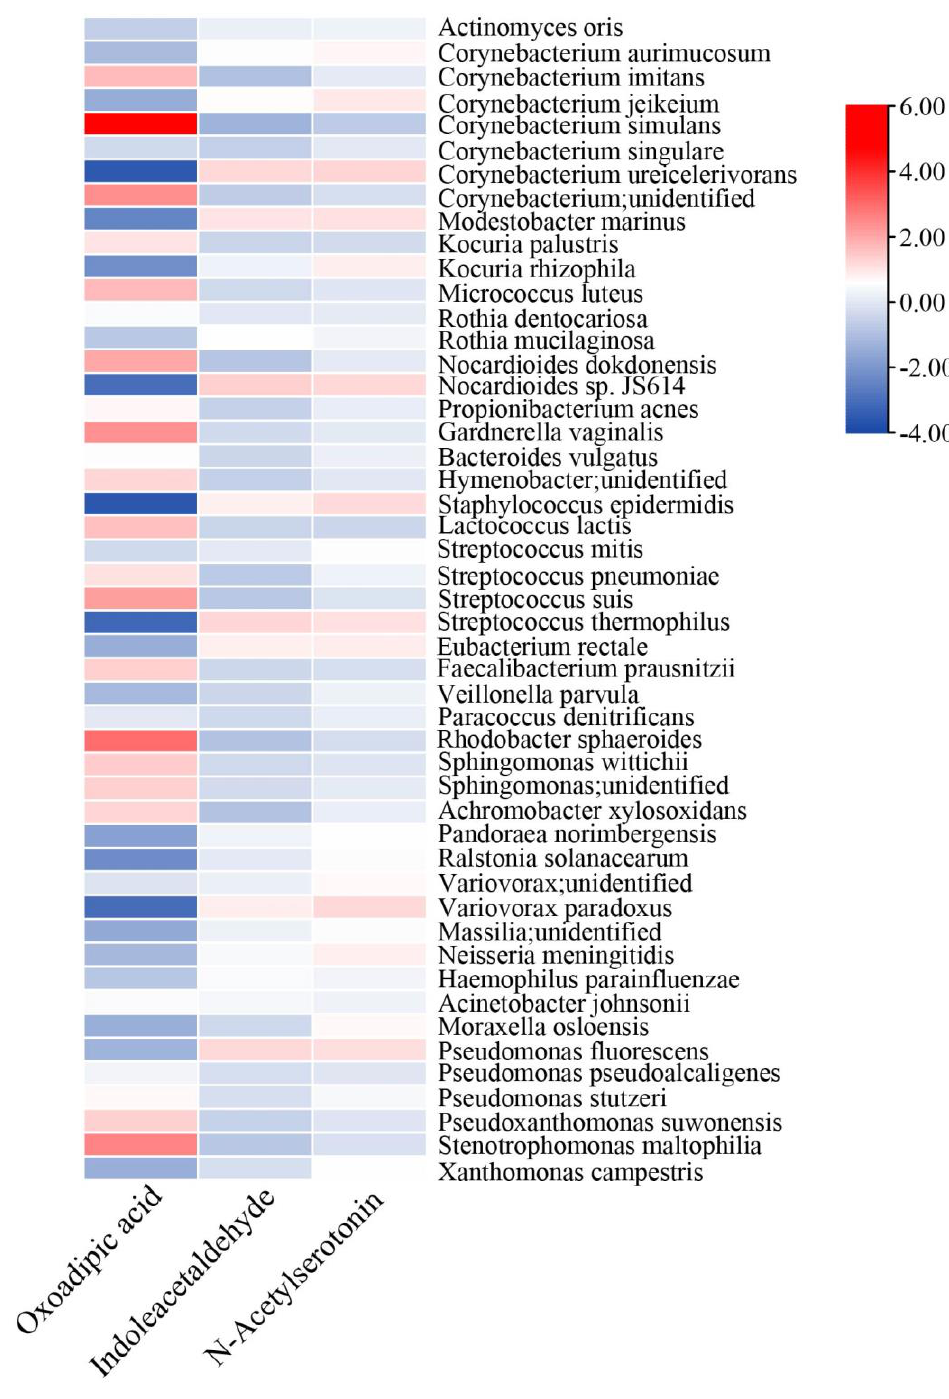
Figure 4. Co-occurrence probability of aircraft microbial taxa and protective metabolites in TSC and LSC. The top 50 microbial taxa present in aircraft cabins are displayed on the y -axis of the heatmap, and the potential protective metabolites (indole and keto acids) are displayed on the x -axis. The co- occurrence probabilities between the microorganisms and metabolites were estimated using mmvec. A positive value indicates a strong likelihood of co-occurrence between the microbe and metabolite.